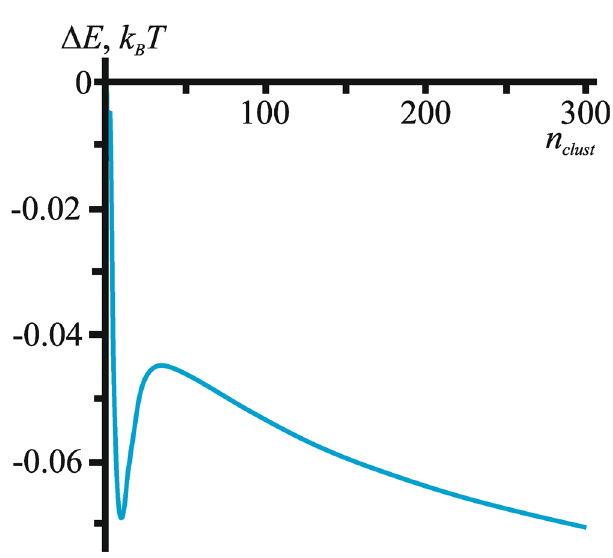
Fig. 6 | Thickness and water properties for all systems simulated. Only atoms contained in a cylinder of radius 30Å and centered at the origin are included (see Supplementary Fig. 7). FPs are in the cis lea fl et (z>0). Left Top) hydrophobic thickness of the POPC and chol:POPC membrane vs numbers of FP. Left Bottom) Values of inverse resistances to water permeability 1/ (cid:1) R (Eq. 7) vs numbers of FP. Error is reported as standard error of the mean, calculated over 250ns block